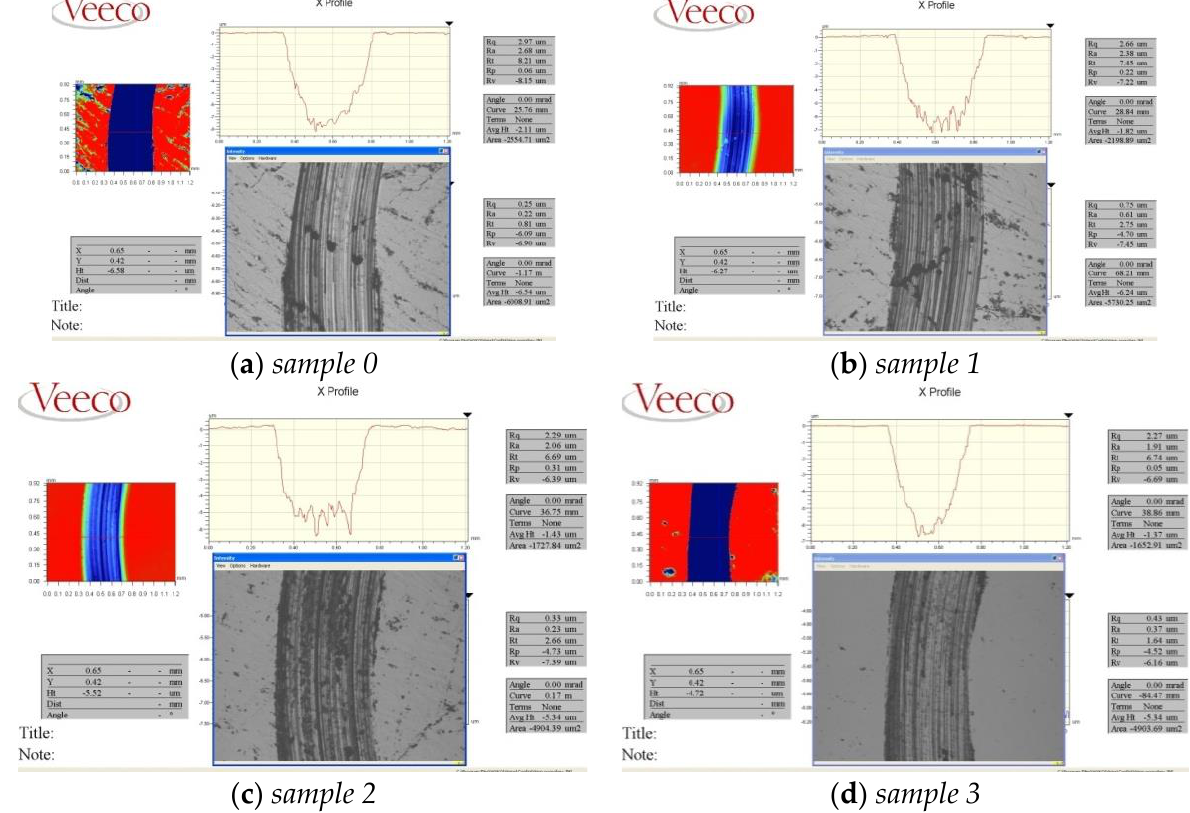
Figure 5. Parameters of the sample wear